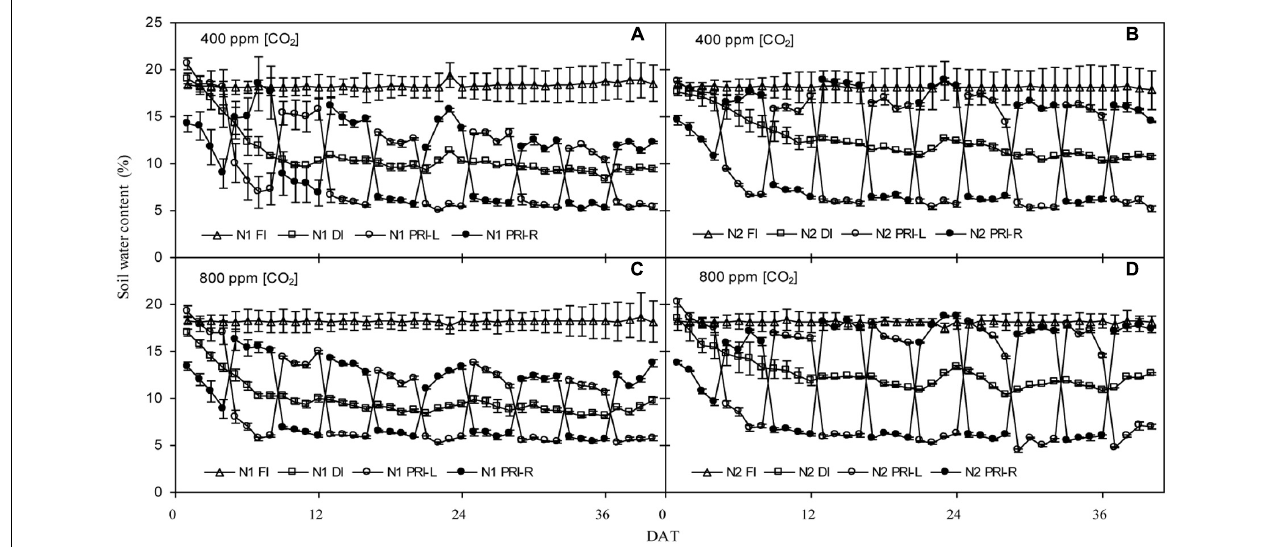
FIGURE 1 | Daily average volumetric soil water content (%) in the pots of tomatoes exposed to three irrigation regimes (full irrigation, FI; deficit irrigation, DI; and alternative partial root-zone irrigation, PRI). PRI-L and PRI-R represent the left and the right soil compartment of the PRI pots, respectively, combined with two N fertilization rates (N1 and N2) under atmospheric 400 ppm [CO 2 ] (A,B) and with two N fertilization rates (N1 and N2) under atmospheric 800 ppm [CO 2 ] (C,D) . Error bars indicate standard error of the mean ( n = 4).